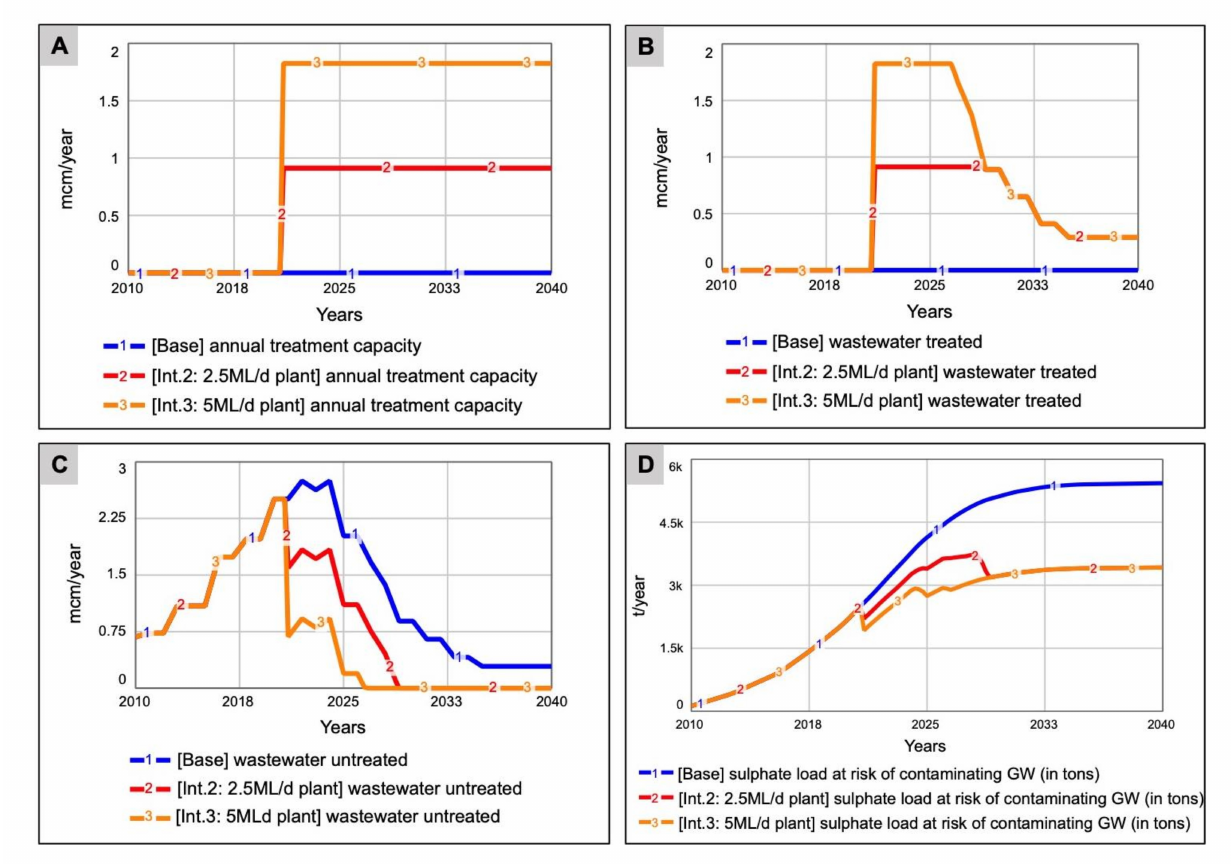
Figure 8. Results for Interventions 2 and 3 (Int.2 and Int.3) which compare two neutralisation treatment plants. Int.2 = a treatment plant with a capacity of 2.5 megalitres per day (ML/d); Int.3 = a treatment plant with a capacity of 5 megalitres per day (ML/d). ( A ) shows the annual treatment capacity; ( B ) compares the quantities of wastewater treated and ( C ) compares the quantities of wastewater left untreated; ( D ) shows the relative sulphate loads at risk of contaminating groundwater (GW). Note that the x -axis is shortened to only display the results from 2010–2040 in order to enhance the legibility of the